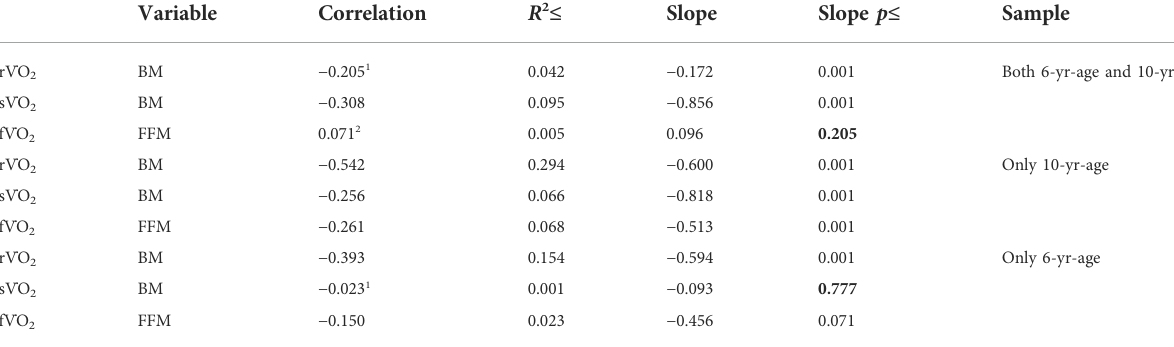
TABLE 3 Effect of controlling for BM or